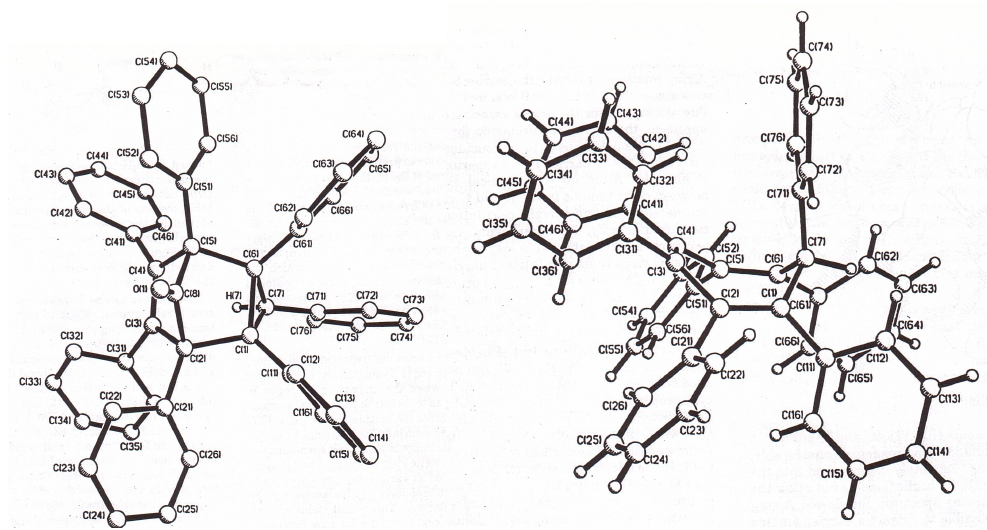
Figure 6. Molecular structures of ( left ) the Diels-Alder adduct of tetracyclone and triphenylcyclopropene, 7 , and ( right ) heptaphenylcycloheptatriene, 6 [29]. Figure 6 is reprinted with permission of the American Chemical Society.